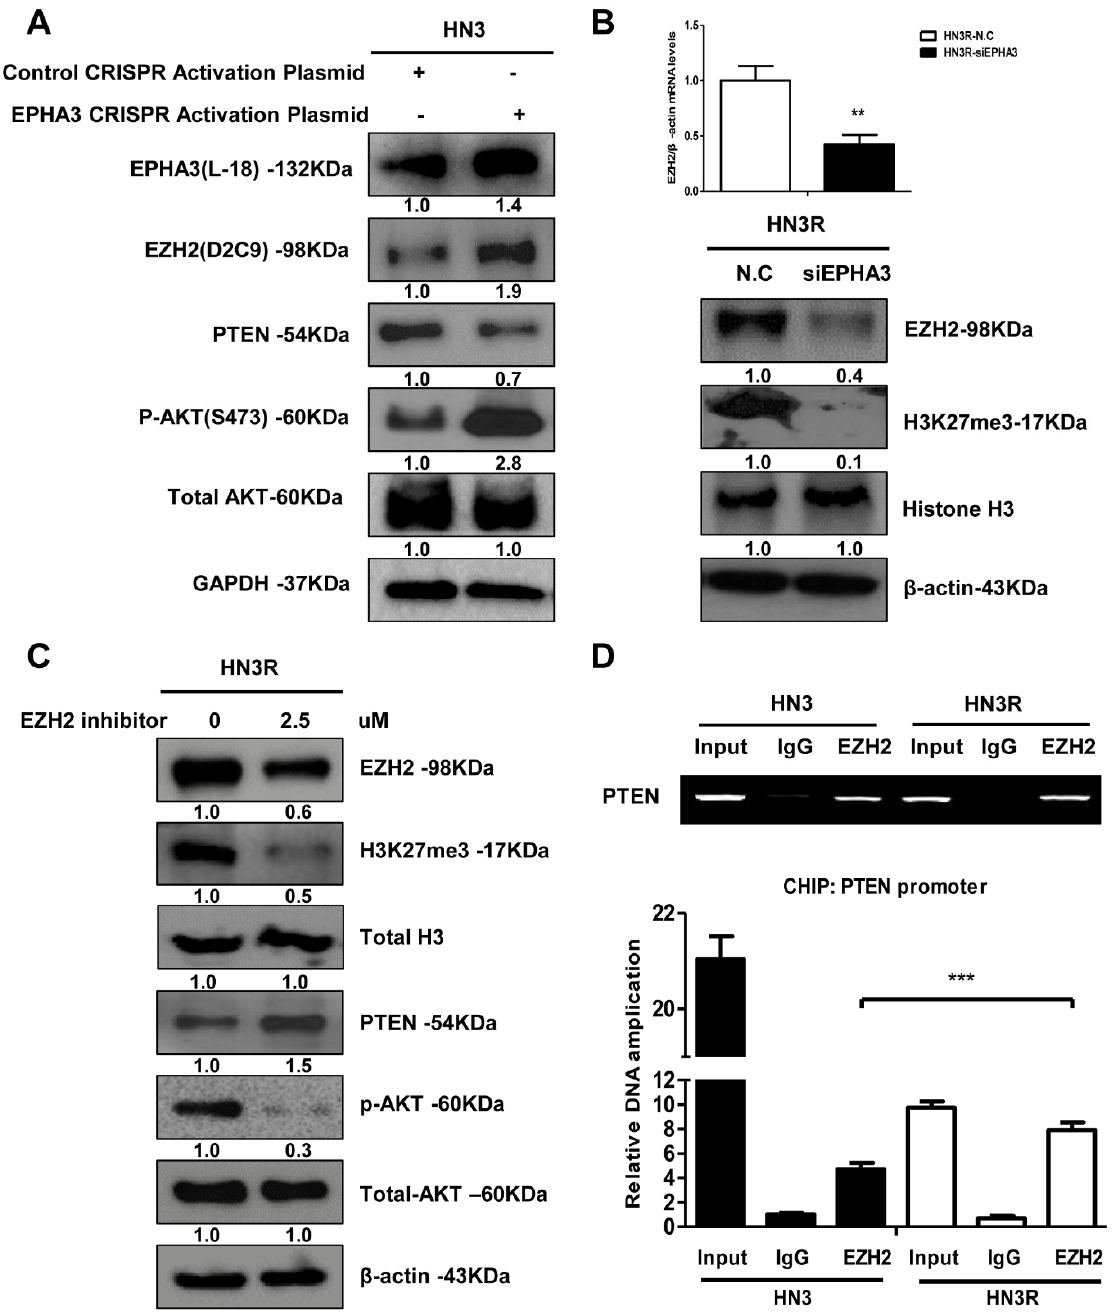
Figure 2. EPHA3 maintains PTEN suppression and Akt activation through EZH2-mediated histone methylation in radioresistant head and neck cancer cells. ( A ) Protein levels of EZH2, PTEN, pAkt, and total Akt in EPHA3 transfected HN3 cells. (-: control, +; CRISPR Activation Plasmid transfection) ( B ) Protein levels of EZH2, H3K27me, and total H3 after the silencing of EPHA3 in HN3R cells, and in EPHA3-overexpressing HN3 cells. ** p < 0.01 ( C ) Expression of PTEN, total H3, pAKT, and total Akt through suppression of H3K27me3 after treatment with the EZH2 inhibitor (2.5 µ M). ( D ) ChIP assays showing endogenous EZH2 bound to the promoter region of PTEN. *** p < 0.001